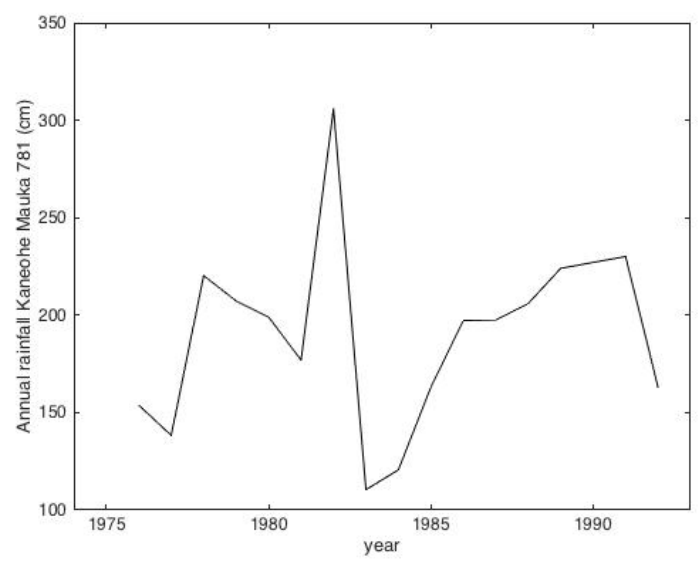
Figure 4. The annual rainfall at Kaneohe Mauka station 781 from 1977 through 1992.